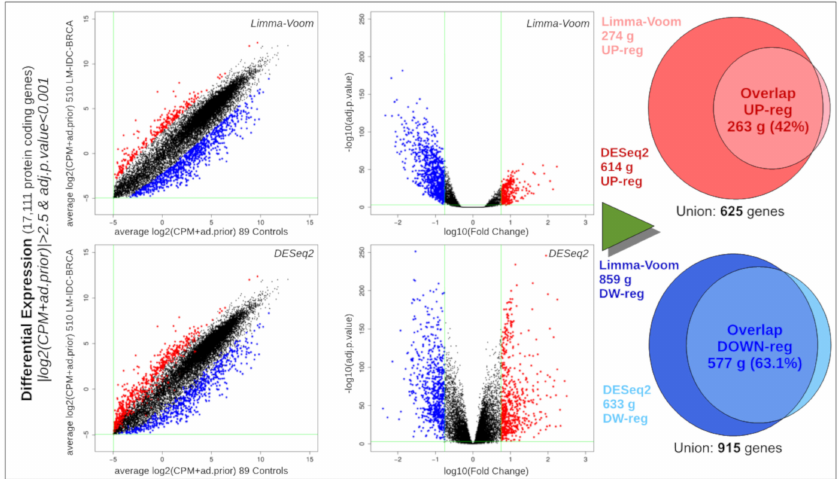
Figure 2. Scatter plots, volcano plots and proportional Venn diagrams showing the results of the di ff erential expression analysis of RNA-seq data from 510 ductal luminal breast cancer samples versus 89 healthy control samples. As indicated in the article, the analyses were done using two algorithms: Limma-Voom (upper scatter plot and volcano plot) and DESeq2 (lower scatter plot and volcano plot). Upregulated genes are marked in red and downregulated genes are marked in